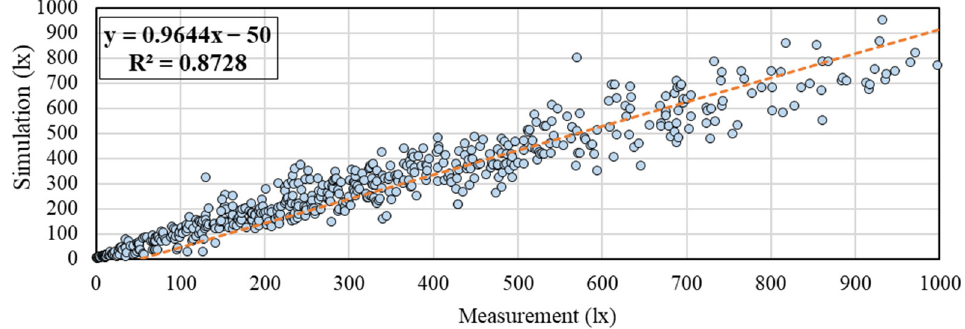
Figure 15. Scatter plot of illuminance. (Illuminance < 1000 lx).